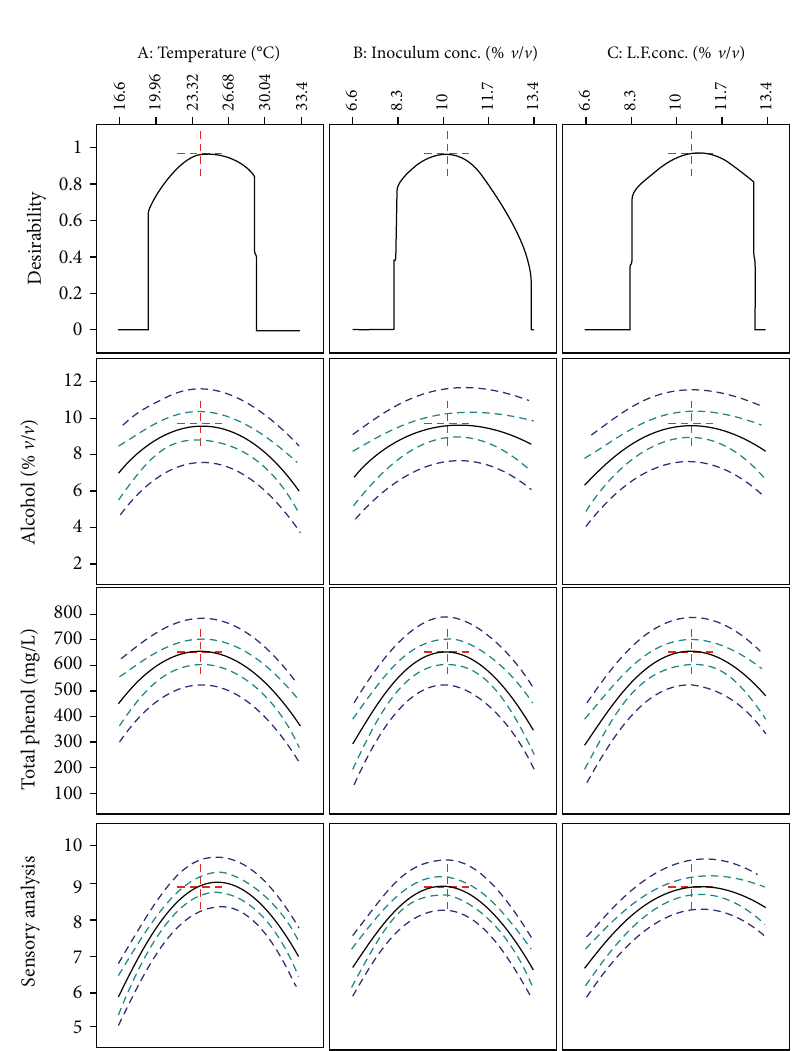
Figure 4: Numerical multiresponse optimization and desirability value (the numbered buttons) across the top correspond to the solution list. Units are temperature in ° C, inoculum and Lantana camara fruit concentration in %, v / v .